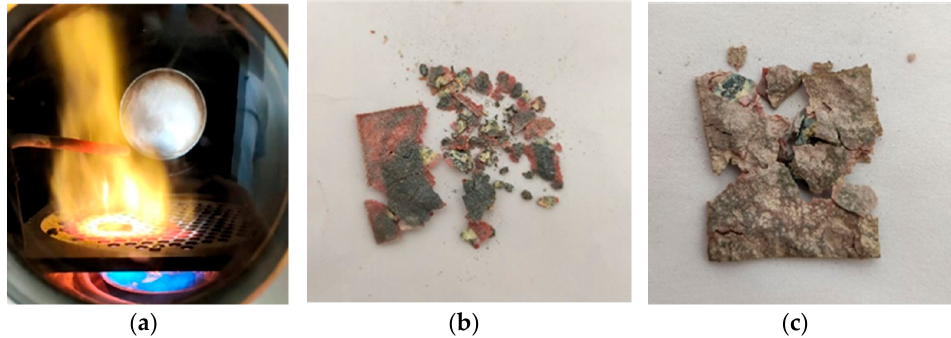
Figure 2. Figure of the burning Cerium and combustion products. (a): The combustion diagram of the cerium sample. (b)and(c): The combustion products of the cerium sample. The filter paper after cerium-aerosol sampling is shown in Figure 3, from right to left and top to bottom, with stages 0–7 and F, respectively. The first line is 0, 1, and 2 stages from right to left. The second line is 3, 4, and 5 stages from right to left. The third line is 6, 7, and F stage from right to left.